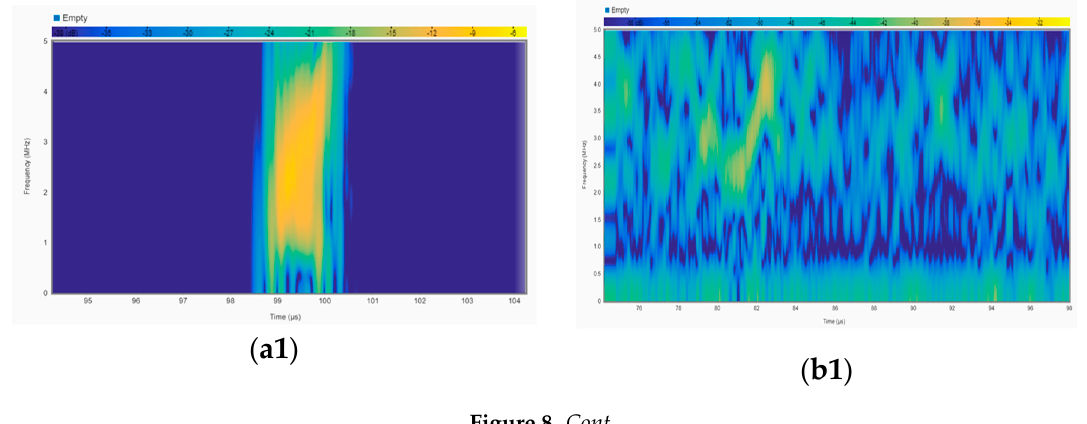
Figure 7. The CAD results for the wave traveling in the liquid, showing the actual total traveled distance for three cases: the ( a ) critical case; ( b ) 1000 µ L case, and ( c ) 1800 µ L case.